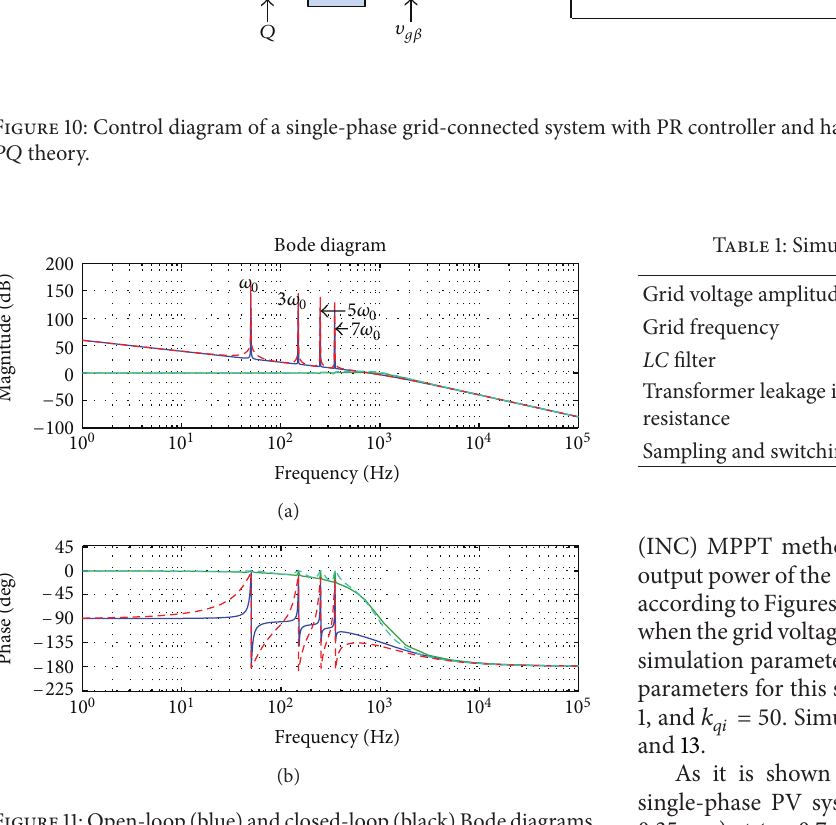
Figure 11: Open-loop (blue) and closed-loop (black) Bode diagrams of the current controller with different sets of 𝑘 𝑖ℎ : 𝑘 𝑝 = 22, 𝑘 𝑖ℎ = 500 (solid line), and 𝑘 𝑖ℎ = 5000 (dashed line), where ℎ = 1, 3, 5, 7.